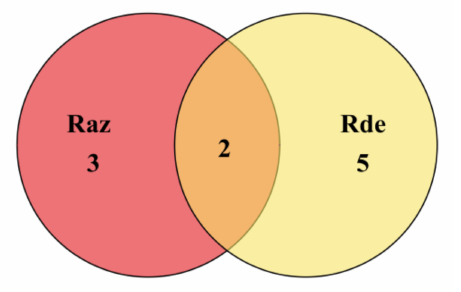
Figure 5. Venn diagram illustrating the the numbers of common and unique positively selected P450s in both Raz and Rde resistant strains of C. pomonella .